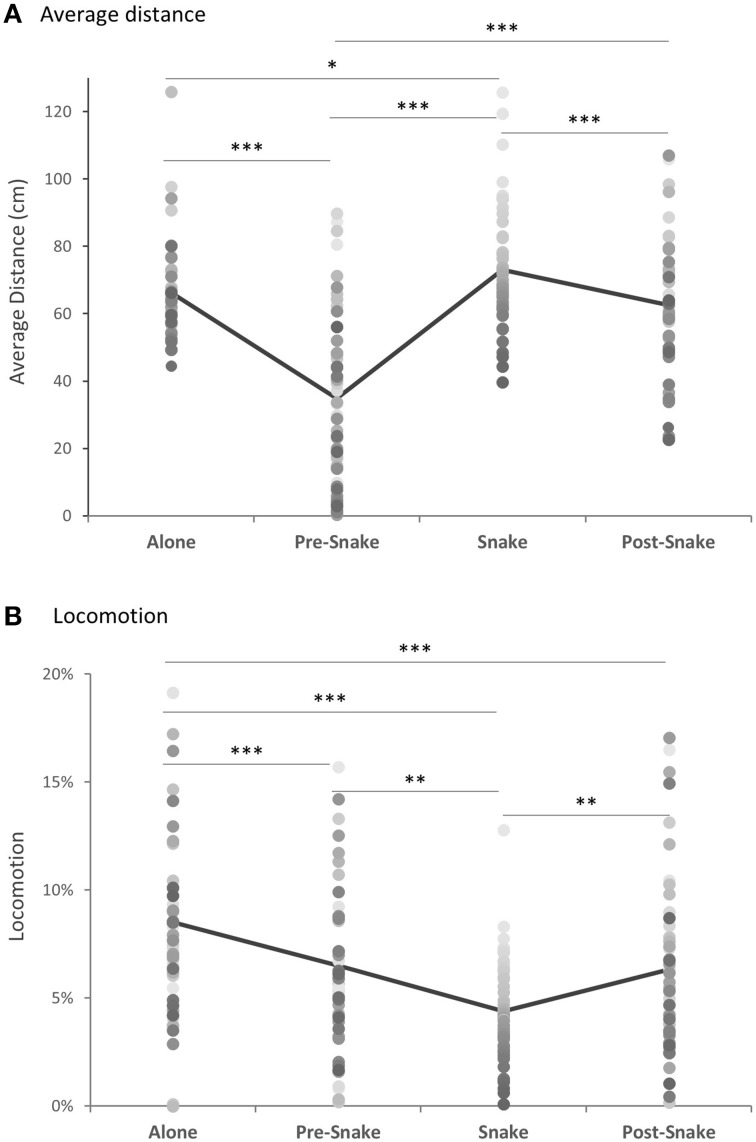
(A) Average distance from the position of the snake box and (B) locomotion, across all phases of the model snake test (n = 49). Gray-shaded dots represent individual animals. *p < 0.05, **p < 0.01, ***p < 0.001.